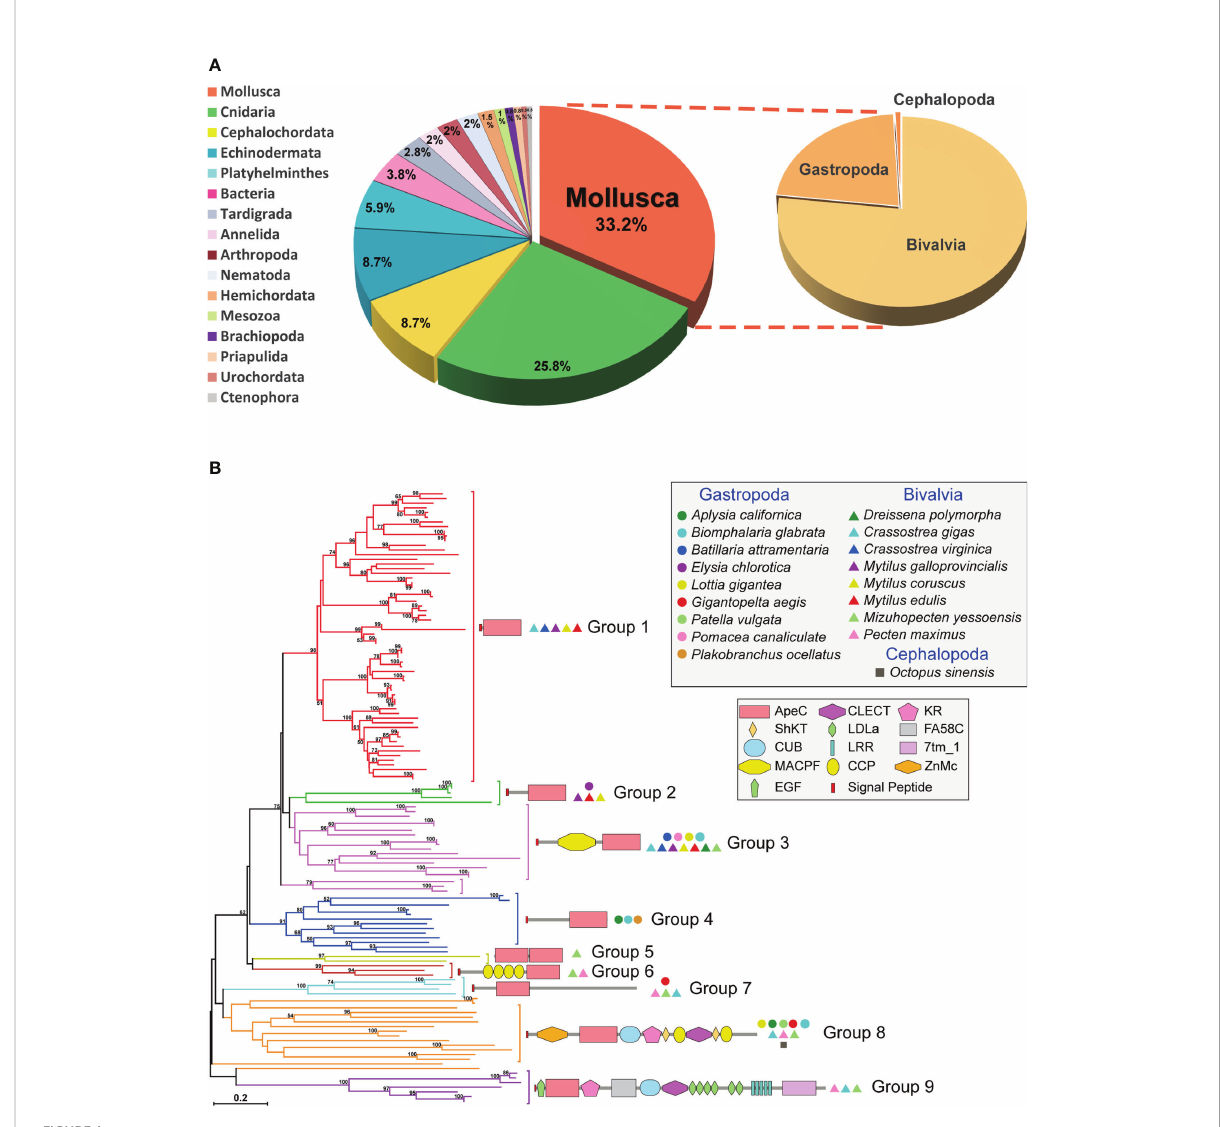
FIGURE 1 The distribution, phylogenetics and domain architectures of 130 mollusk ACPs. (A) The proportion of ACPs in different phyla. (B) A phylogenetic tree of all 130 mollusk ACPs based on the ApeC domain. The tree was constructed using the neighbor-joining method. The percentage of replicate trees in which the associated taxa clustered together in the bootstrap test (1000 replicates) are shown next to the branches. The protein architectures, grouping and source species are shown in corresponding positions. A Maximum Likelihood tree based on the same alignment is also provided in Supplementary Figure 1. A full list of these mollusk ACPs is provided in Supplementary Table